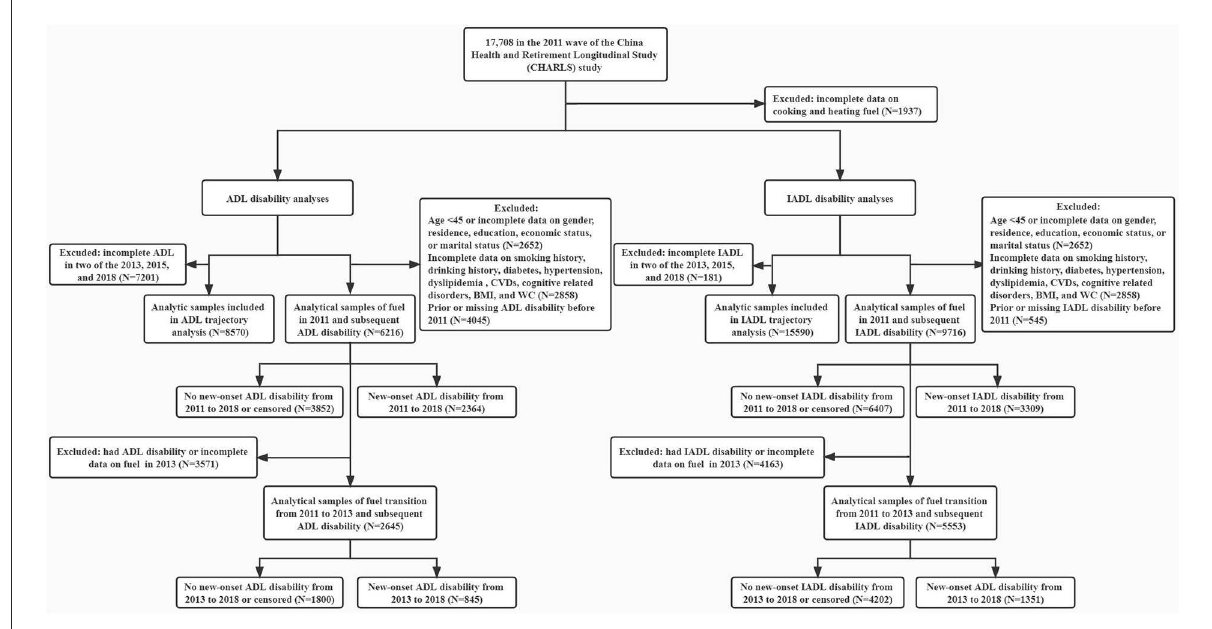
FIGURE1 Flow chart. ADL, activity of daily living; IADL, instrumental activity of daily living; CVD, cardiovascular disease; BMI, body mass index; WC, waist circumference.